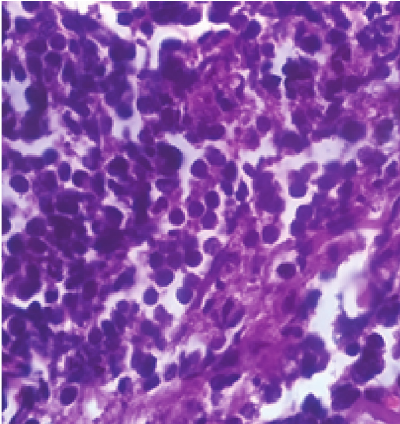
Figure 3: Bone marrow smear showing immature cells with blue cytoplasm, round nuclei, and